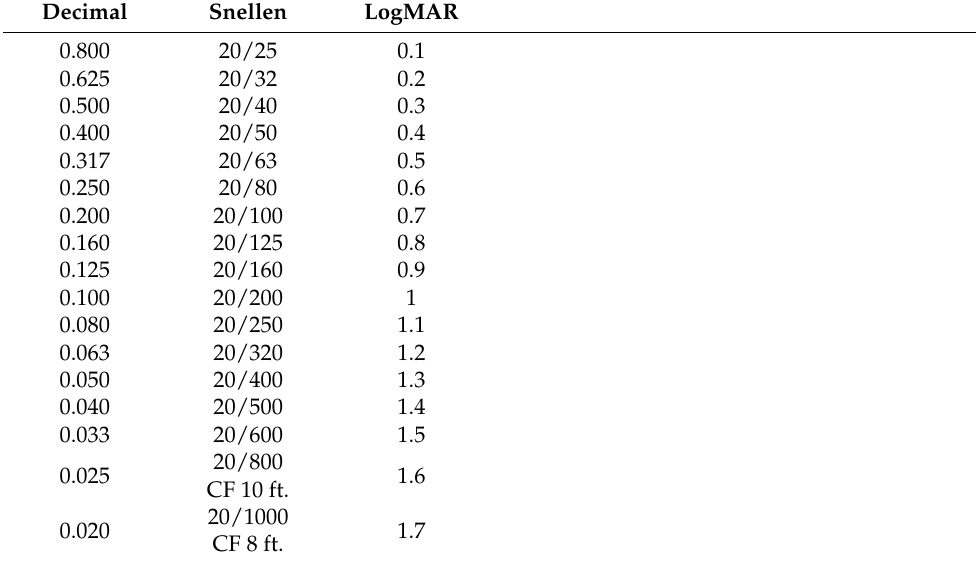
Table 1. Assessment of lines of vision improvement. Equivalent decimal, Snellen and LogMAR acuity